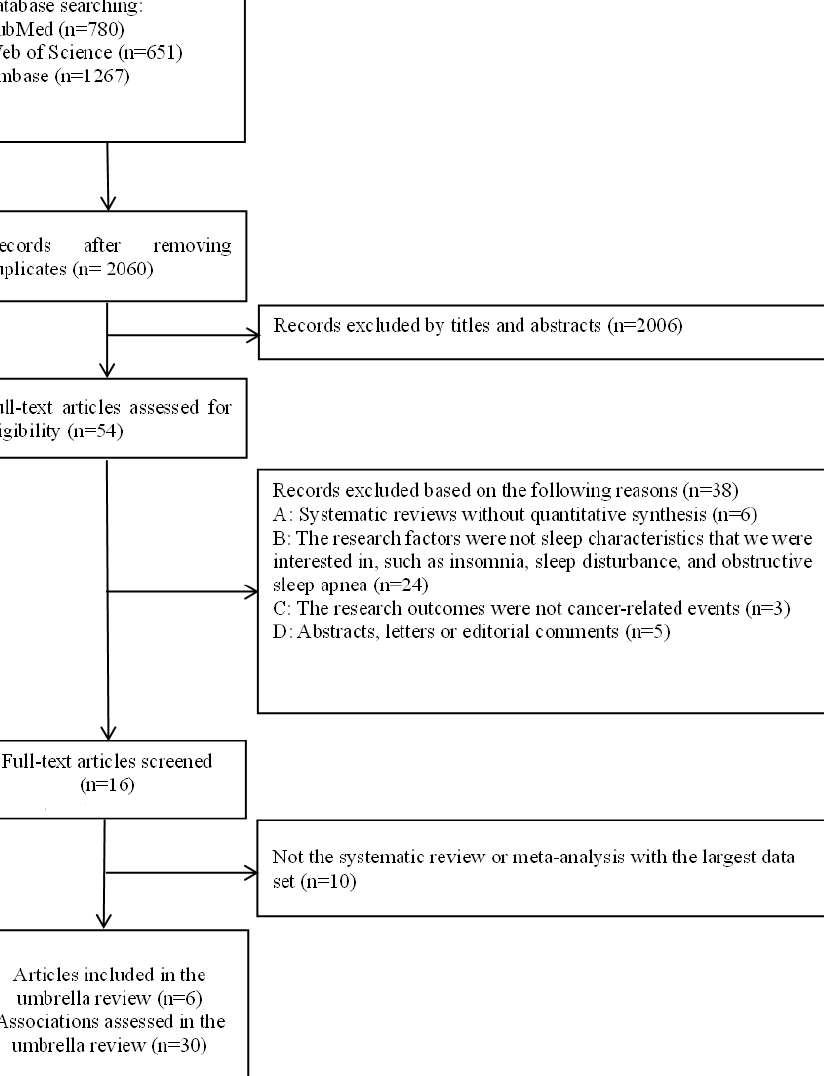
Figure 1. Flowchart of the literature search and